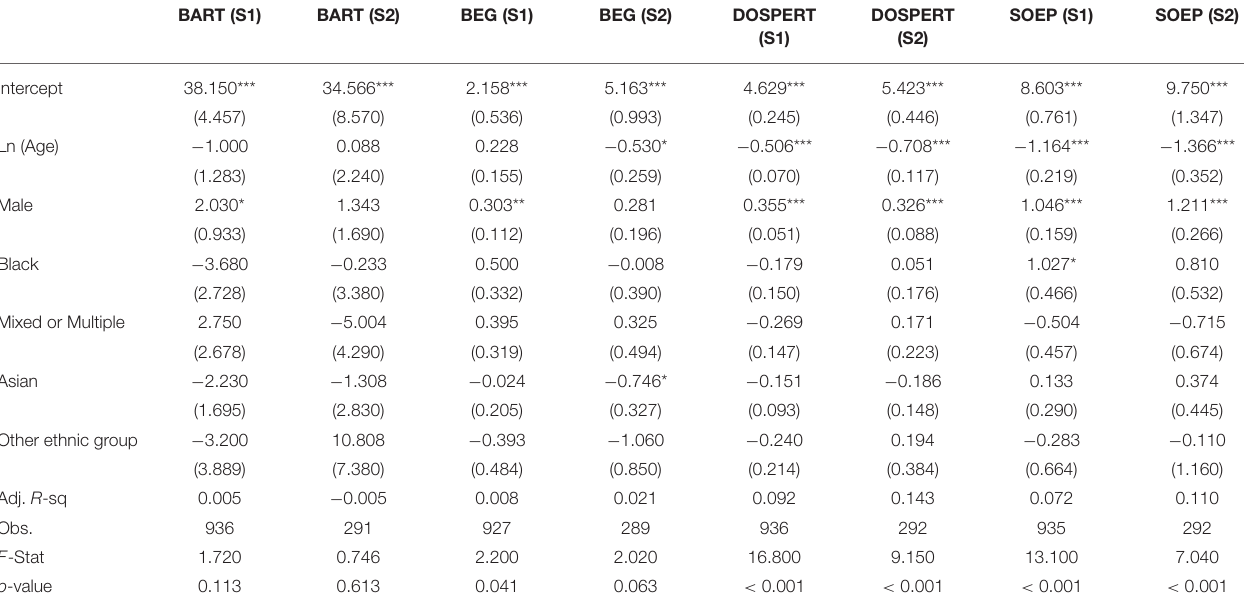
TABLE 1 | Linear regression analysis—main risk measures across the two studies regressed on the exogenous participant